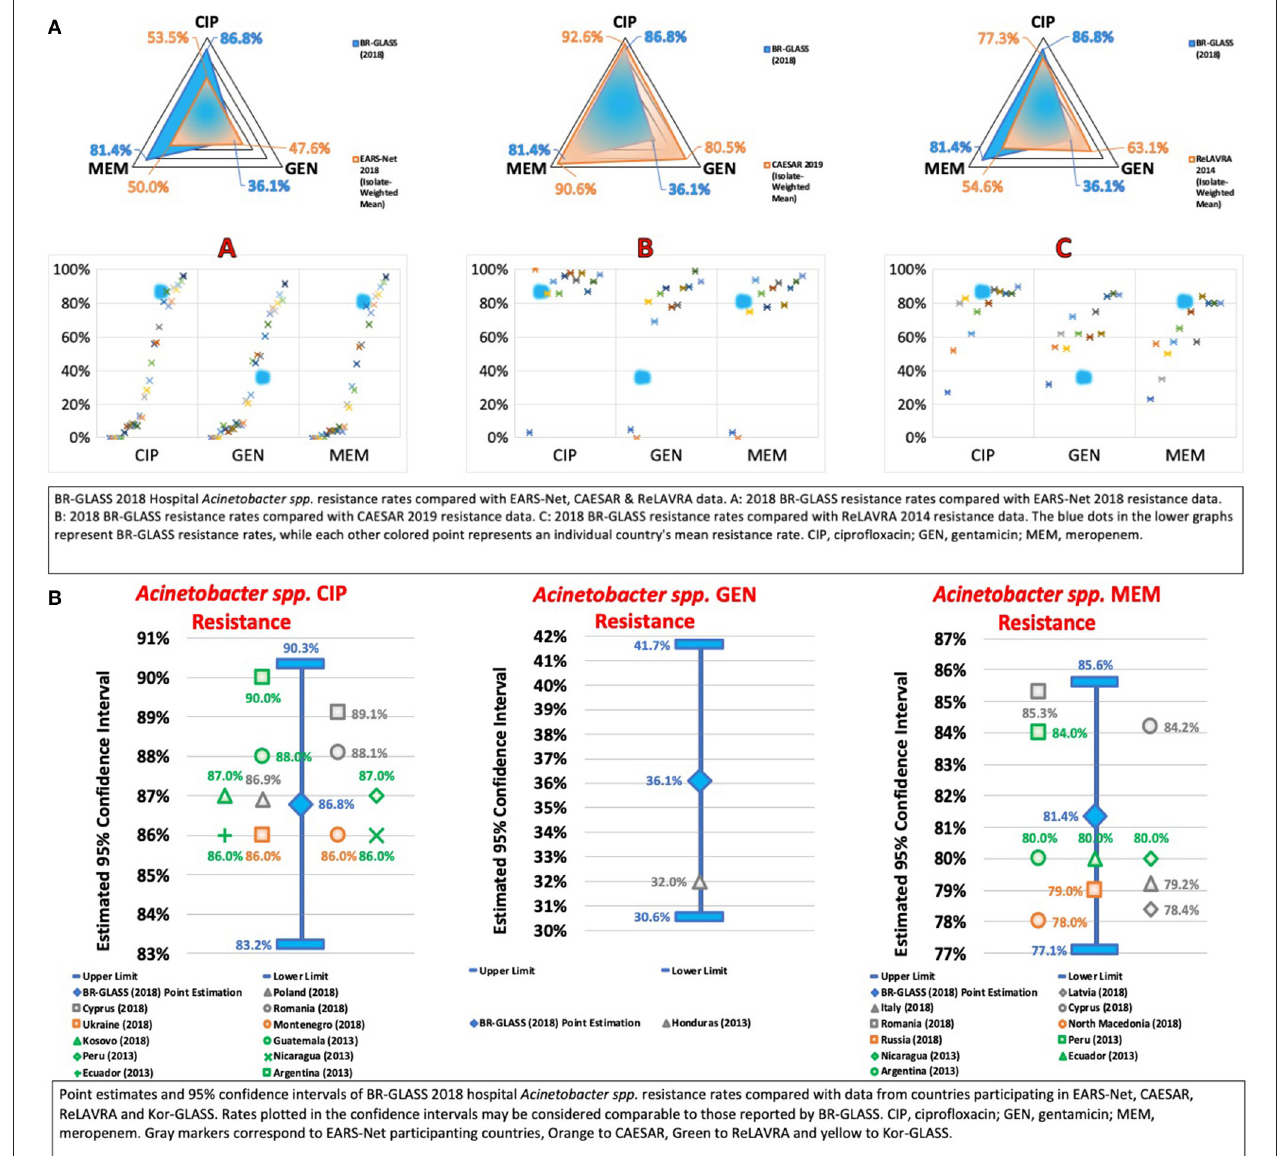
FIGURE 10 | (A) BR-GLASS 2018 Hospital Acinetobacter spp. resistance rates compared with general EARS-Net, CAESAR, and ReLAVRA data. (B) BR-GLASS 2018 Hospital Acinetobacter spp. estimated resistance rates with 95% confidence intervals and comparable rates reported in different